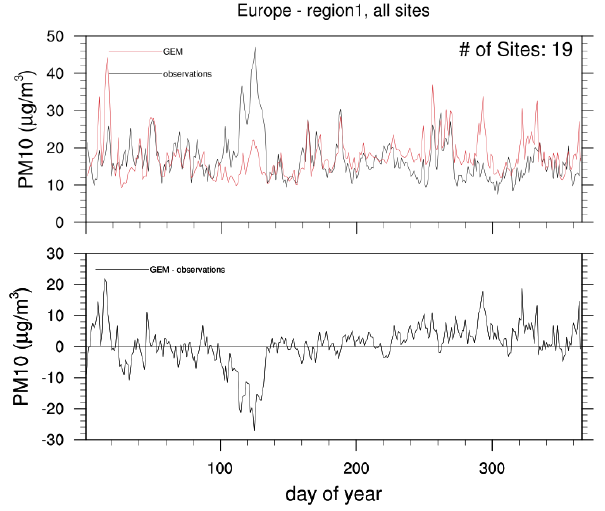
Figure 21. Time series of observed and modelled PM 10 24h con- centration averaged for all stations in central Europe and MBE.